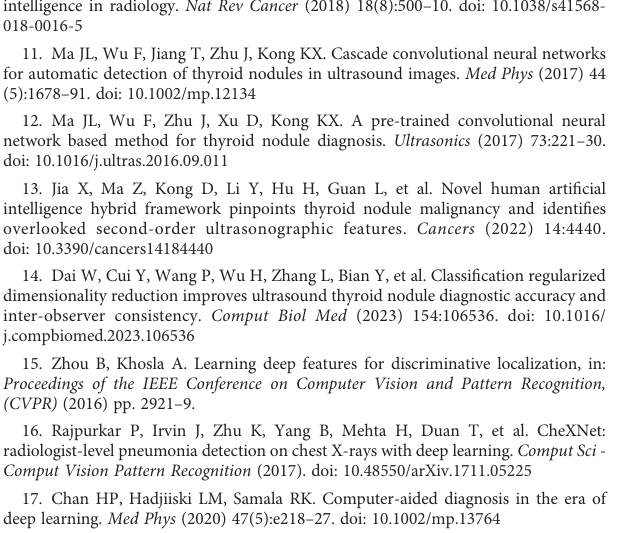
SUPPLEMENTARY FIGURE 1 In fl uence of adding gradient sign noise perturbations to ultrasound images of different magnitudes b. (a and d) The original image of thyroid nodule and its surroundings. (b and e) The generated gradient sign noises with the respective magnitude of 0.0136 and 0.05. (c and f) The resulting images corresponding to noise perturbations given by panels b and e. (g) The measurement of how the diagnosis performances (by AUC values) of the AICADx system are in fl uenced by noise perturbations with magnitudes b ranging from 0 to 0.1. SUPPLEMENTARY FIGURE 2 The ROC curve of the AI-CADx system for thyroid nodule diagnosis and the corresponding AUC value. SUPPLEMENTARY FIGURE 3 The diagnostic performance of the AI-CADx system directly on segmented regions above the binarization CAM threshold (represented as a ratio to the maximum temperature intensity